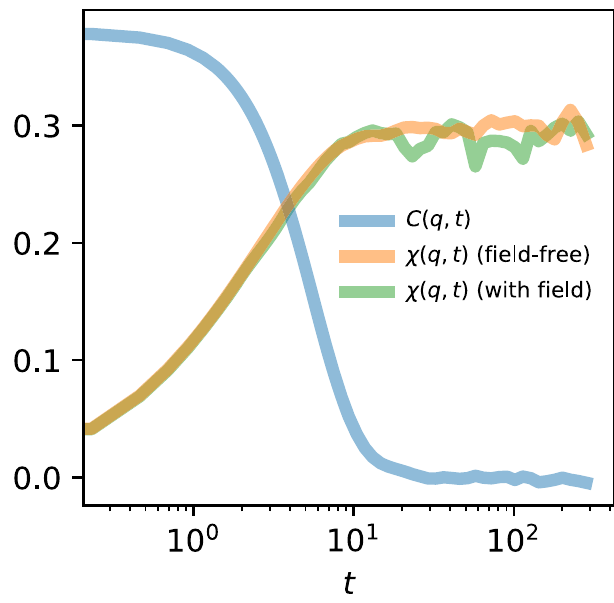
Fig. 1 Perturbed and spontaneous dynamics of active Ornstein-Uhlenbeck particles. The fi eld-free method allows to extract the correlation function of the spontaneous fl uctuations C ( q , t ) (blue curve) and the integrated response function χ ( q , t ) (orange curve). The latter coincides with the response obtained by directly applying the fi eld (green curve). The curves are evaluated at the near-critical state point τ = 16.5 and ρ =